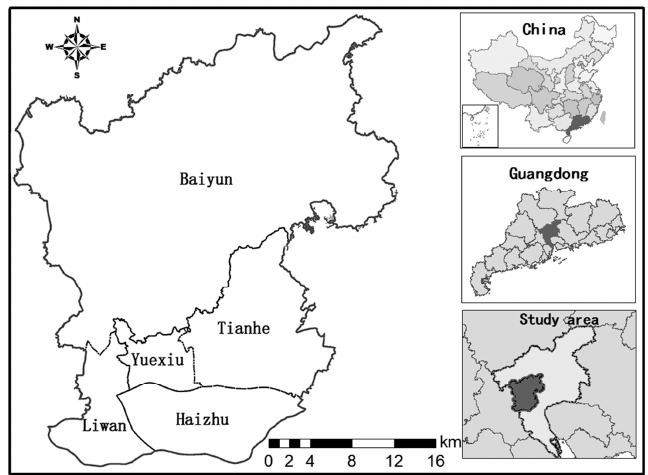
Figure 1. Location of the study area (the geographic extent is 113°8 ′ 43 ″ E to 113°30 ′ 39 ″ E and 23°2 ′ 30 ″ N to 23°25 ′ 40 ″ N). to 23 ◦ 25 (cid:48)